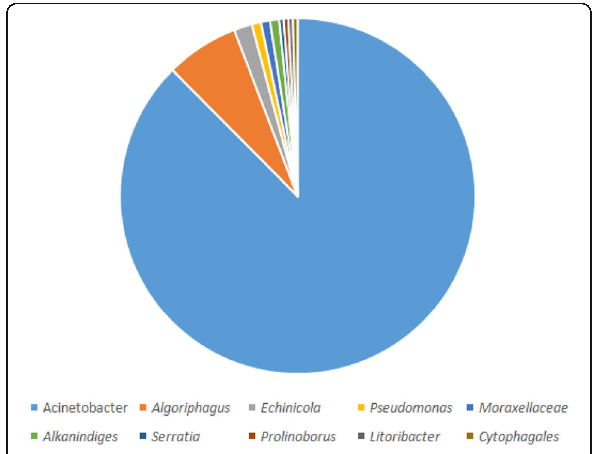
Fig. 2 Similarity pie diagram of MurB from A . baumannii and its related sequences from various genus obtained from PSI-BLAST search against